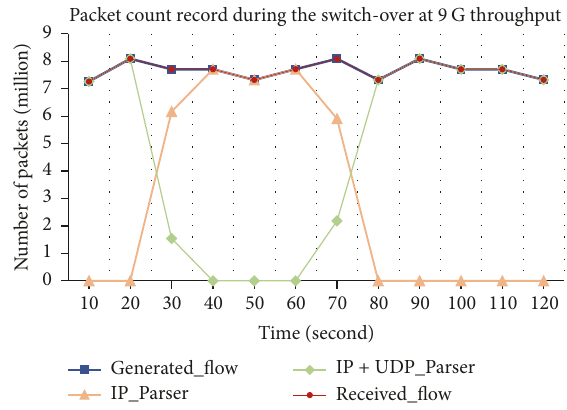
Figure 13: Network function virtualization in data